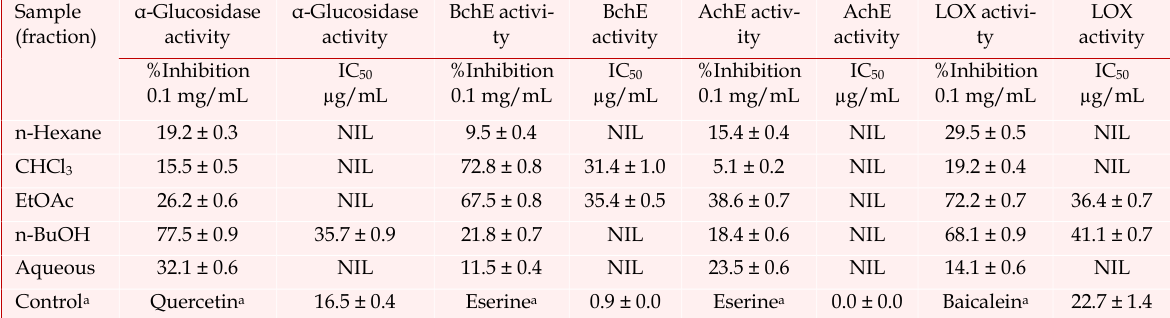
Enzyme inhibition activities of various fractions of Ranunculus sceleratus against α - glucosidase, butyrylcho- lines-terase, acetylcholinesterase and